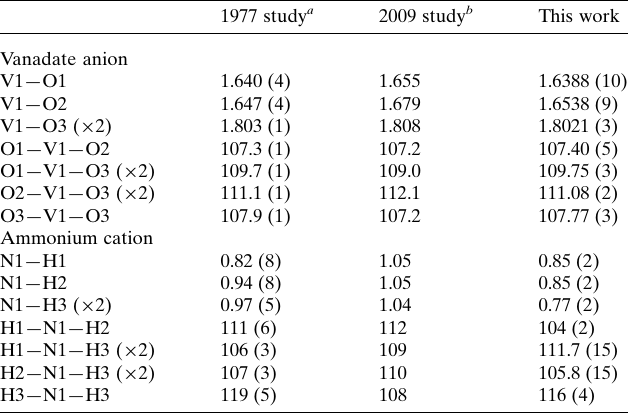
Table 1 Bond lengths (A˚ ) and angles ( (cid:5) ) in NH 4 VO 3 determined in this work compared to those reported in previous studies. The labelling scheme for atomic sites is identical in the three studies.